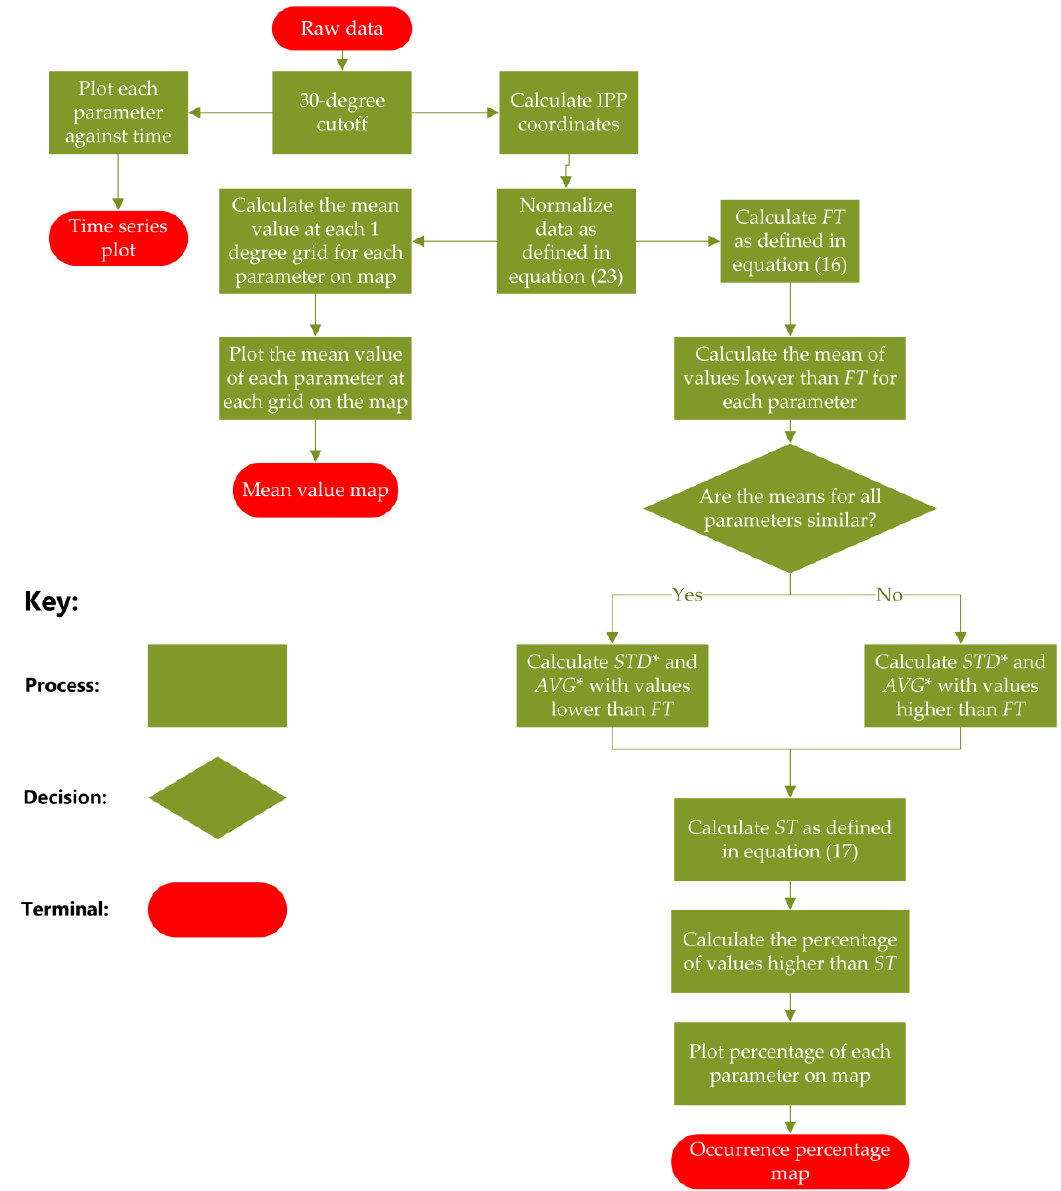
Figure 1. Flow chart for data processing and visualization.